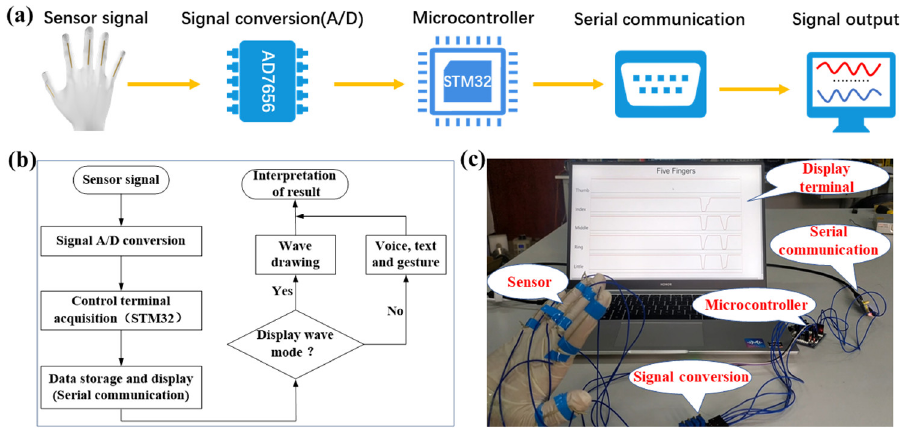
Figure 4. The SPTS-based intelligent sign language translation system. ( a ) Implementation scheme. ( b ) Flow chart. ( c ) Actual photograph.